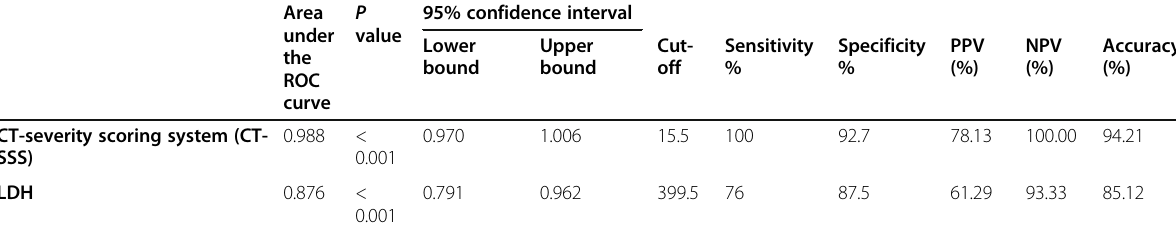
Table 4 ROC curve cut-off value for critical cases using CT-SSS and LDH